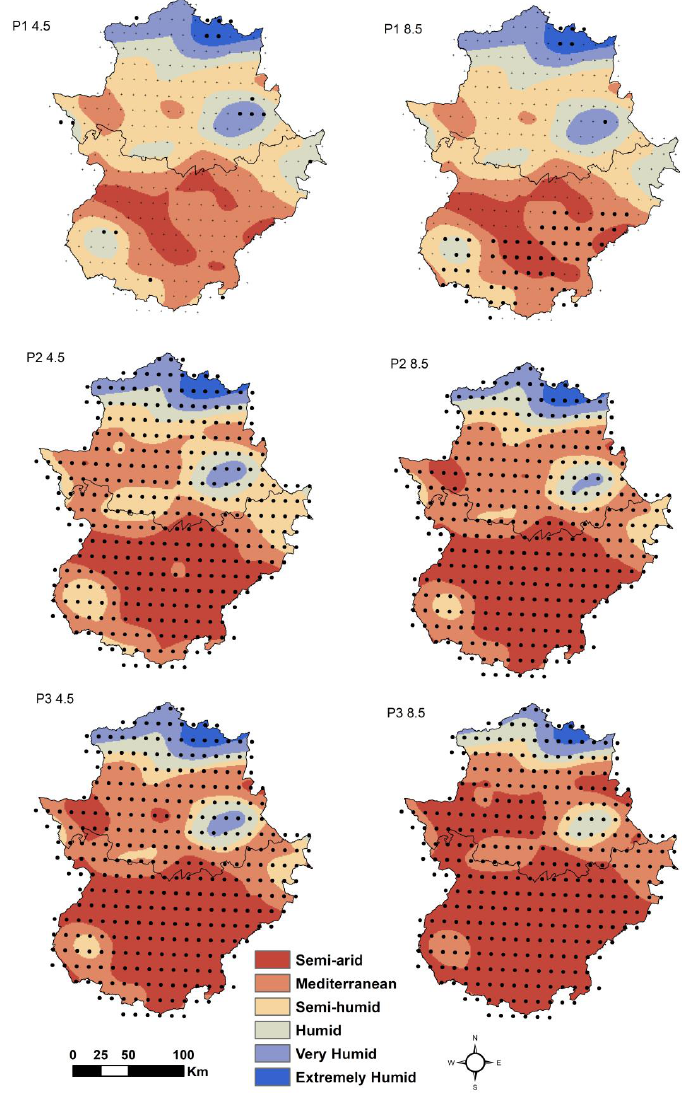
Figure 6. Spatial distribution of the De Martonne aridity index in Extremadura considering the near future (P1), 2006–2035, the mid-century (P2), 2036–2065, and the end of the century (P3) 2066–2095, under two different scenarios, RCP4.5, and RCP8.5. According to Tukey’s test, changes relative to the baseline period, 1971–2005, in dotted locations are statistically significant at a 5% significance